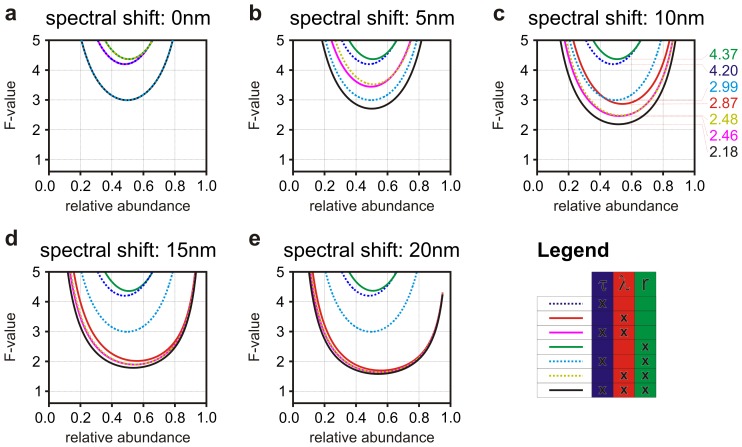
Biochemical resolving power.Panels a–e show the numerical estimations of the F-value of the same optical signatures used in Fig. 4 at increasing spectral shift for FLIM (dashed blue curve), spectral imaging (red), anisotropy imaging (green), SLIM (fuchsia), time resolved anisotropy (dashed cyan curve), spectrally resolved anisotropy (dashed yellow curve) and HDIM (black). Spectral imaging does not achieve F-values in the regions plotted in panel a and b because of the small spectral shifts considered (0 nm and 5 nm, respectively). Panel c shows also the minimum -values for each technique: e.g., with ∼2.18, HDIM unmixed the signatures of the two fluorophores with a relative error of ∼5% if at least 1,900 photons/pixel are collected. Spectral imaging alone requires ∼(2.87/2.18)2 times more photons (∼3,300) to achieve the same result.